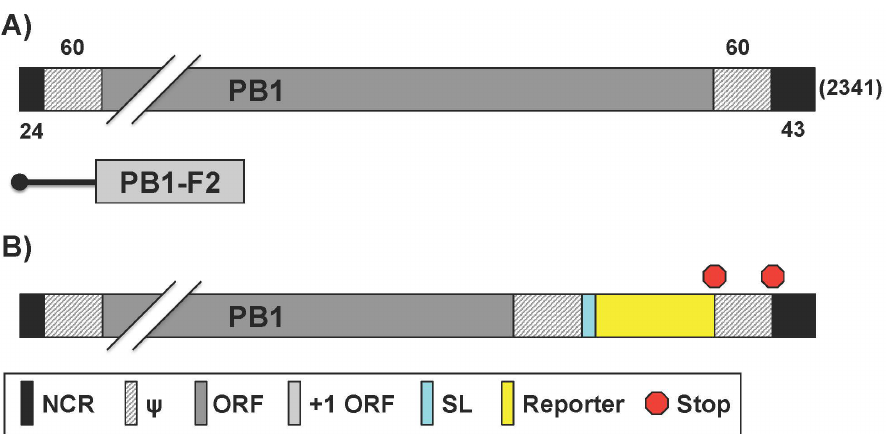
Figure 3. PB1 reporter influenza A viruses: Schematic representation of the PB1 segment from WT ( A ) and reporter ( B ) viruses as described in Figure 1. Influenza A WT PB1 viral segment encodes for both PB1 and PB1-F2 in the +1 ORF via an alternative start codon. Nucleotide lengths for the NCR, ψ , and PB1 segment are indicated; ( B ) PB1 fusion protein: Reporter genes were fused to native PB1 ORF with a short linker (SL). Packaging signals were duplicated after protein stop transcription signal and before the 3’ NCR